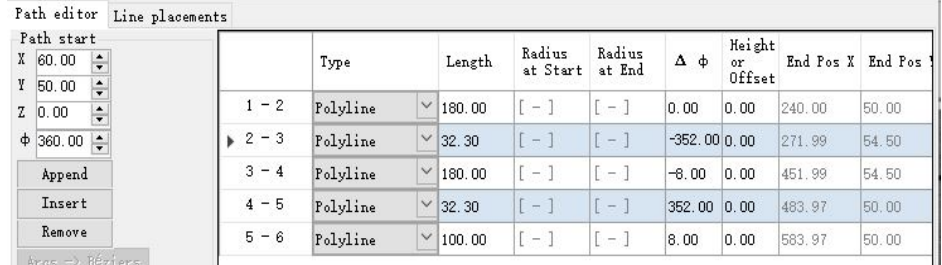
( b ) Figure 14. Images of the start and end moments of the vehicle lane change to the left: ( a ) Image of the start moment of the vehicle lane change to the left; ( b ) Image of the end moment of the vehicle lane change to the left. ( a )